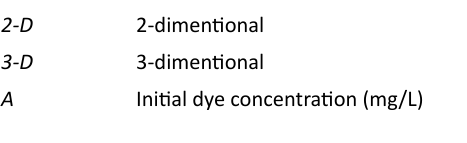
Fourier Transform Infrared